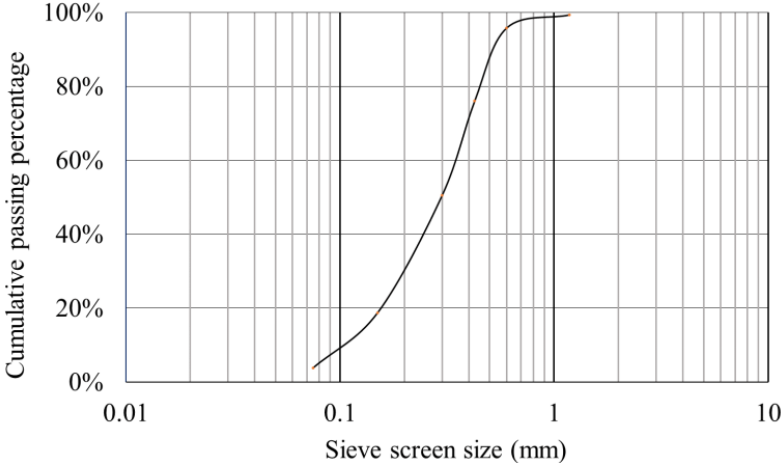
Figure 3. Red sand particle size distribution.